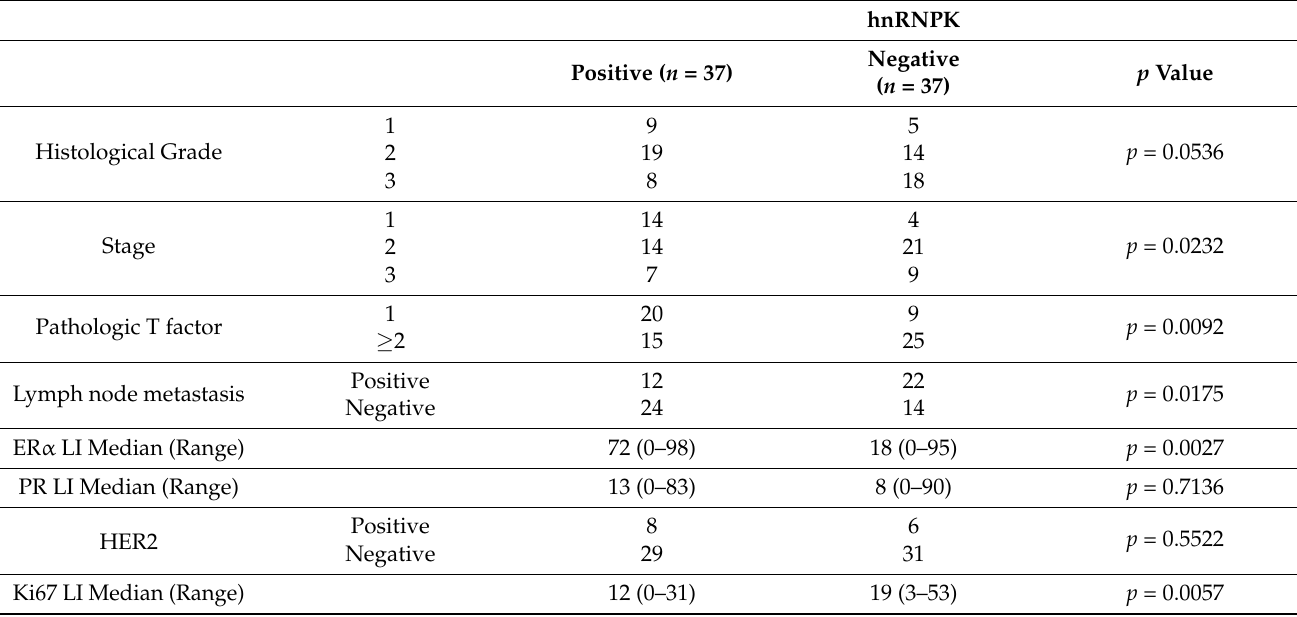
Figure 4. hnRNPK, ER α , and Ki67 immunoreactivity in patients with breast cancer. Case 1 yielded high hnRNPK and ER α expressions, but low Ki67 expression. Case 2 yielded low hnRNPK and ER α expressions, but high Ki67 expression. Scale bar, 50 µm. Table 1. Association of hnRNPK with clinicopathological parameters in breast cancer patients.